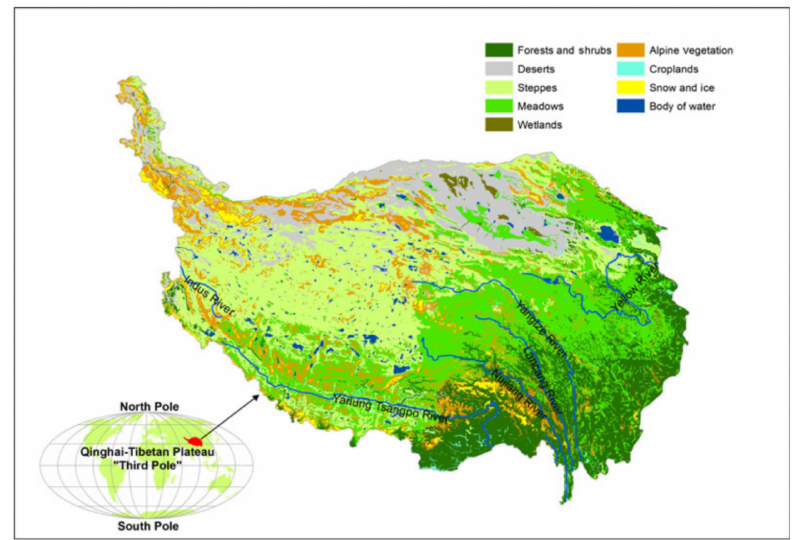
Figure B1. Distribution of vegetation types on the Tibetan Plateau, which is regarded as the “third pole” of the Earth. The complex cli- mate conditions cause a diverse vegetation pattern, resulting in the local plant communities highly sensitive to global climate change. The southeastern margin of the plateau is dominated by shrubs and forests. This figure originated from Chen et al. (2013).